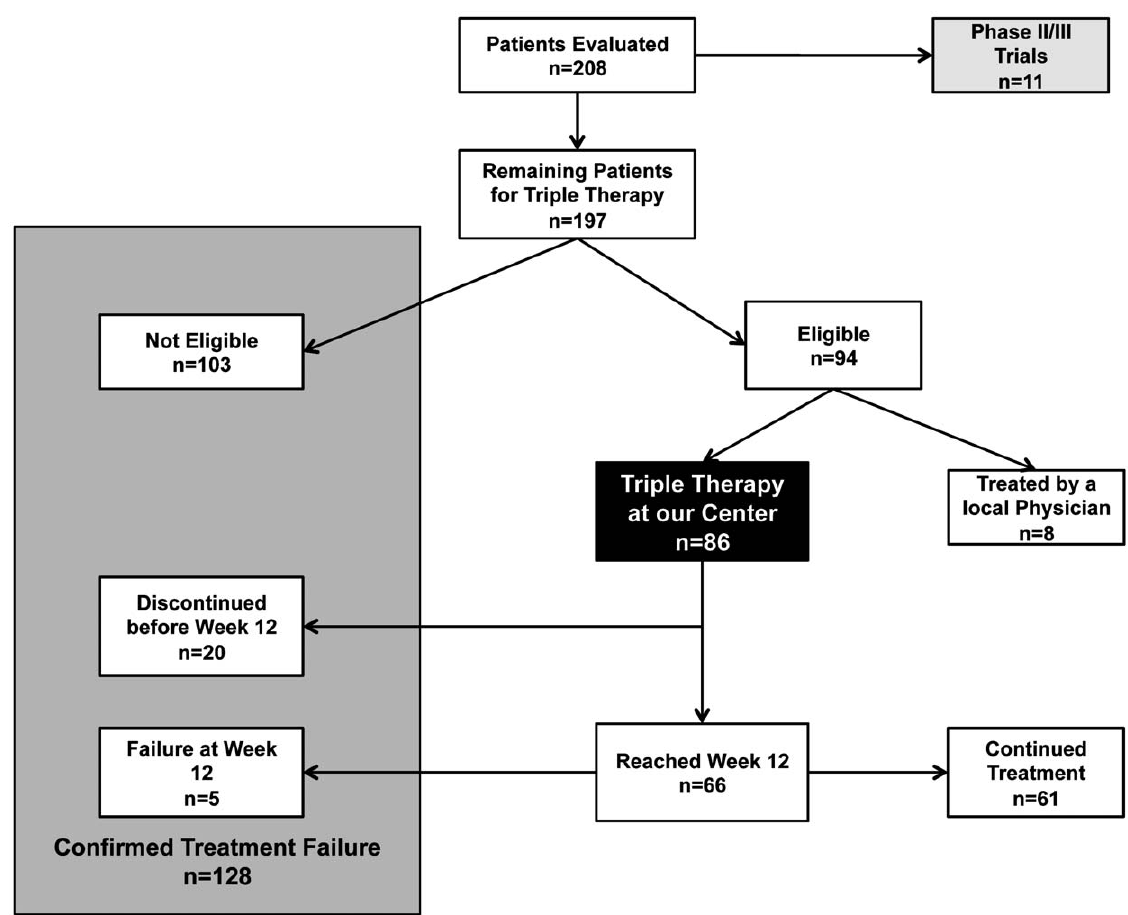
Figure 3. Overall outcome of the evaluation process and treatment period.